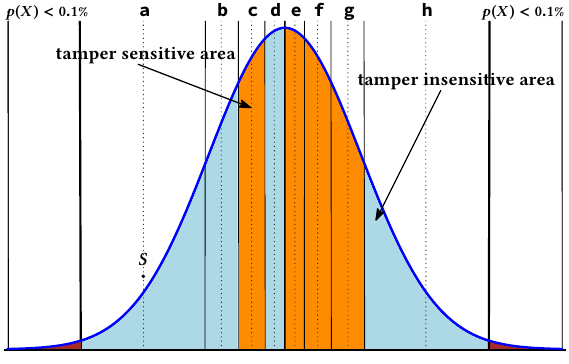
Figure 7: TS max of Profile 5 for the symbol S as indicated. Based on the Gray code bit node mapping as illustrated in Figure 2b and as further detailed in Appendix